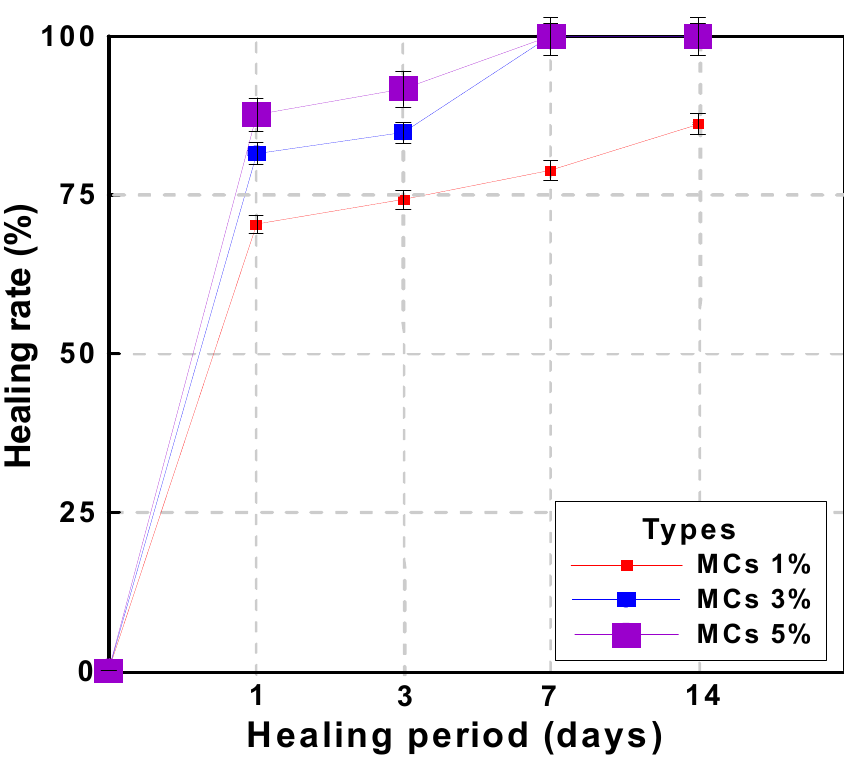
Figure 16. Correlation between healing period and healing rate on the MCs 0%.